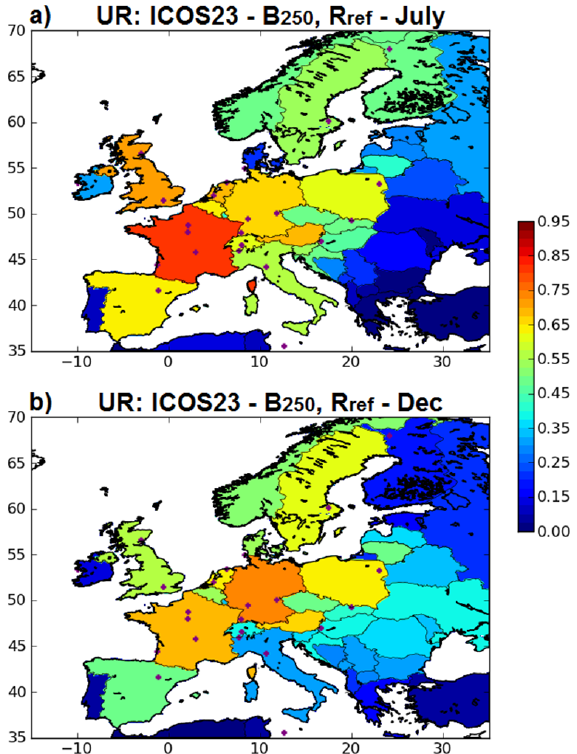
Figure 4. Uncertainty reduction (theoretically comprised between 0 and 1) for a 2-week-mean NEE at the country scale for July (a) and December (b) when using ICOS23 and the reference inversion con- figuration. Red/blue colors indicate relatively high/low uncertainty reduction (with min = 0 and max = 0.95 in the color scale).